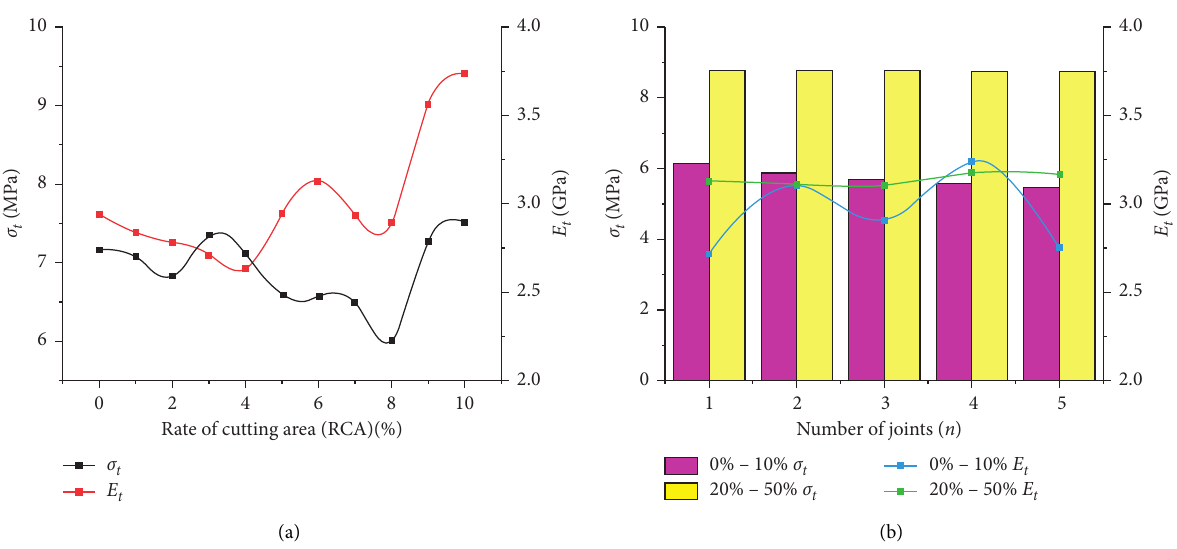
Figure 11: Changes in mechanical properties under different RCAs and different ( n ).